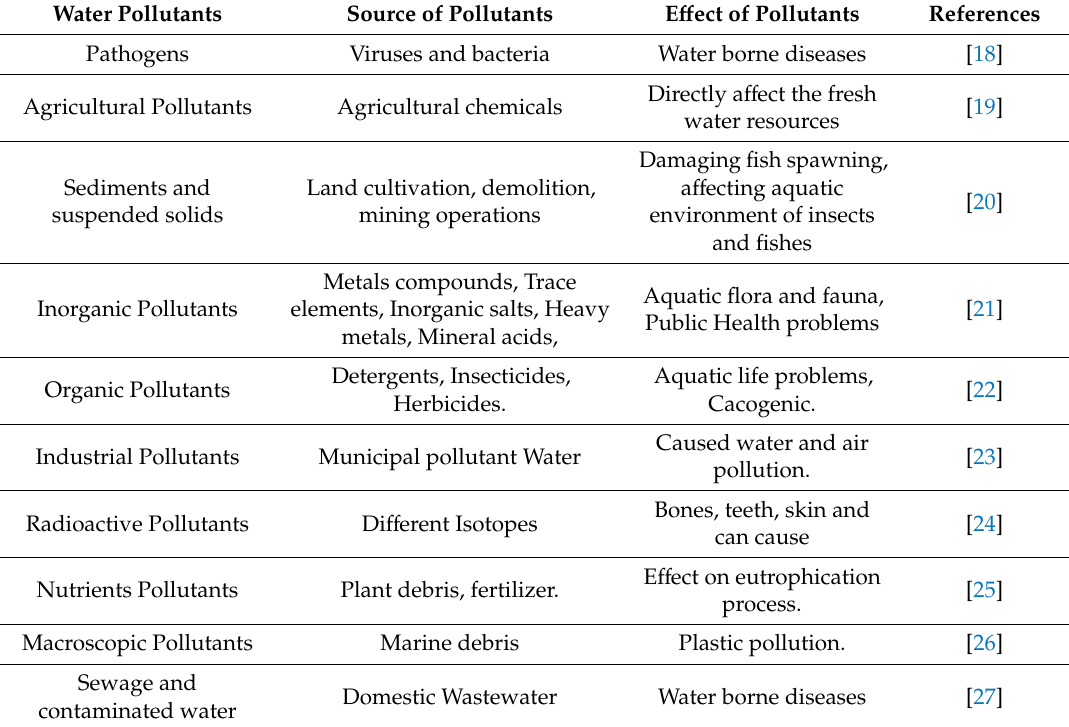
Table 1. Indicates di ff erent water pollutants with their sources and adverse e ff